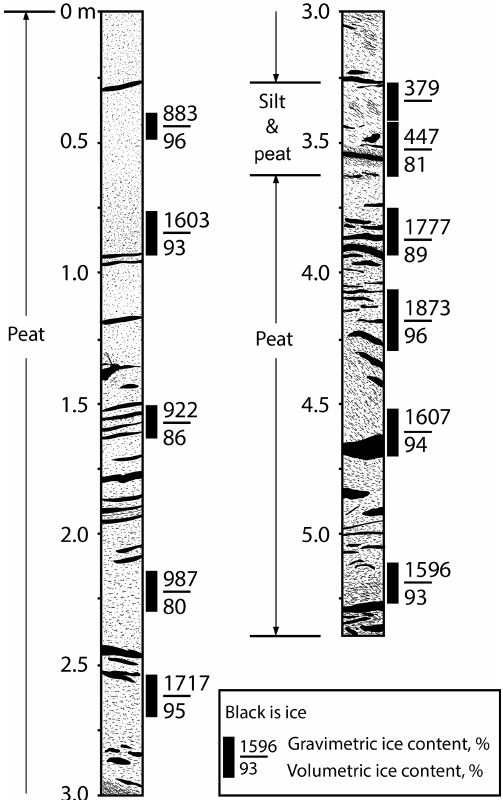
Figure 8. Cryostratigraphy and ice contents from borehole PF-BL-6 (inspired by Kanevskiy et al., 2014). The gravimetric and volumet- ric ice contents of the peat varied between 883–1873 and 80–96%, respectively, while they were 379–447 and 81%, respectively, in the silt and peat layer located between 3.32 and 3.65m.